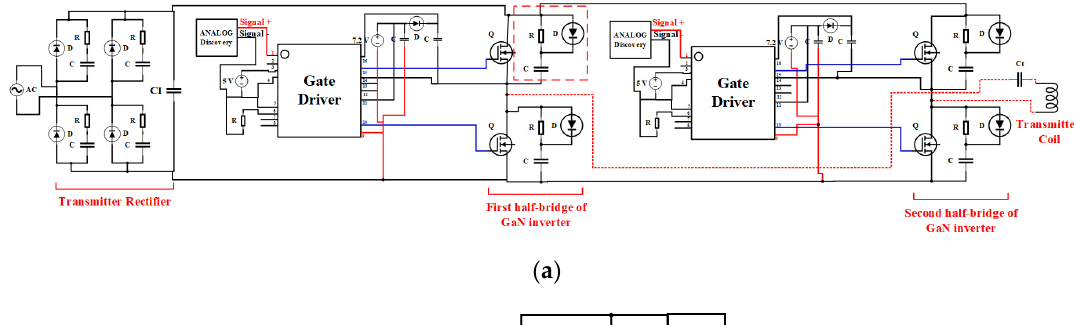
Figure 1. Wireless charging circuit contains: ( a ) AC voltage source, transmitter rectifier, GaN inverter with gate drivers, and transmitter coil; ( b ) Receiver coil, receiver rectifier, and battery.